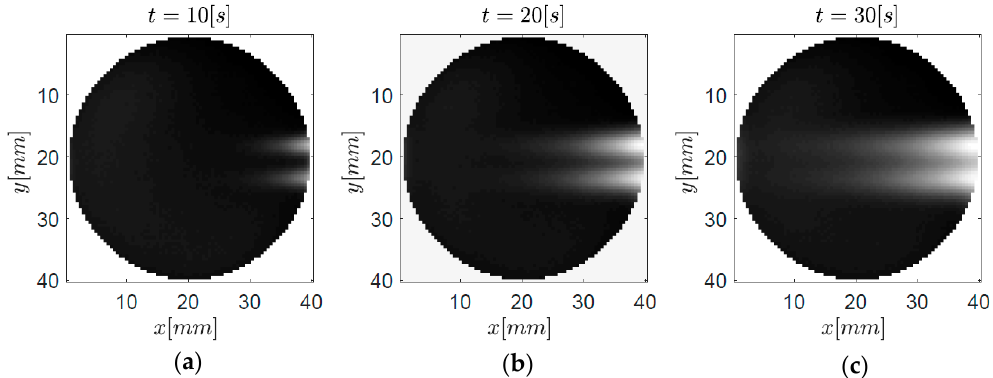
Figure 3. Principal sketch of the experimental set up to obtain experimental data for the validation of the acoustic reconstruction of infrared measurement data.